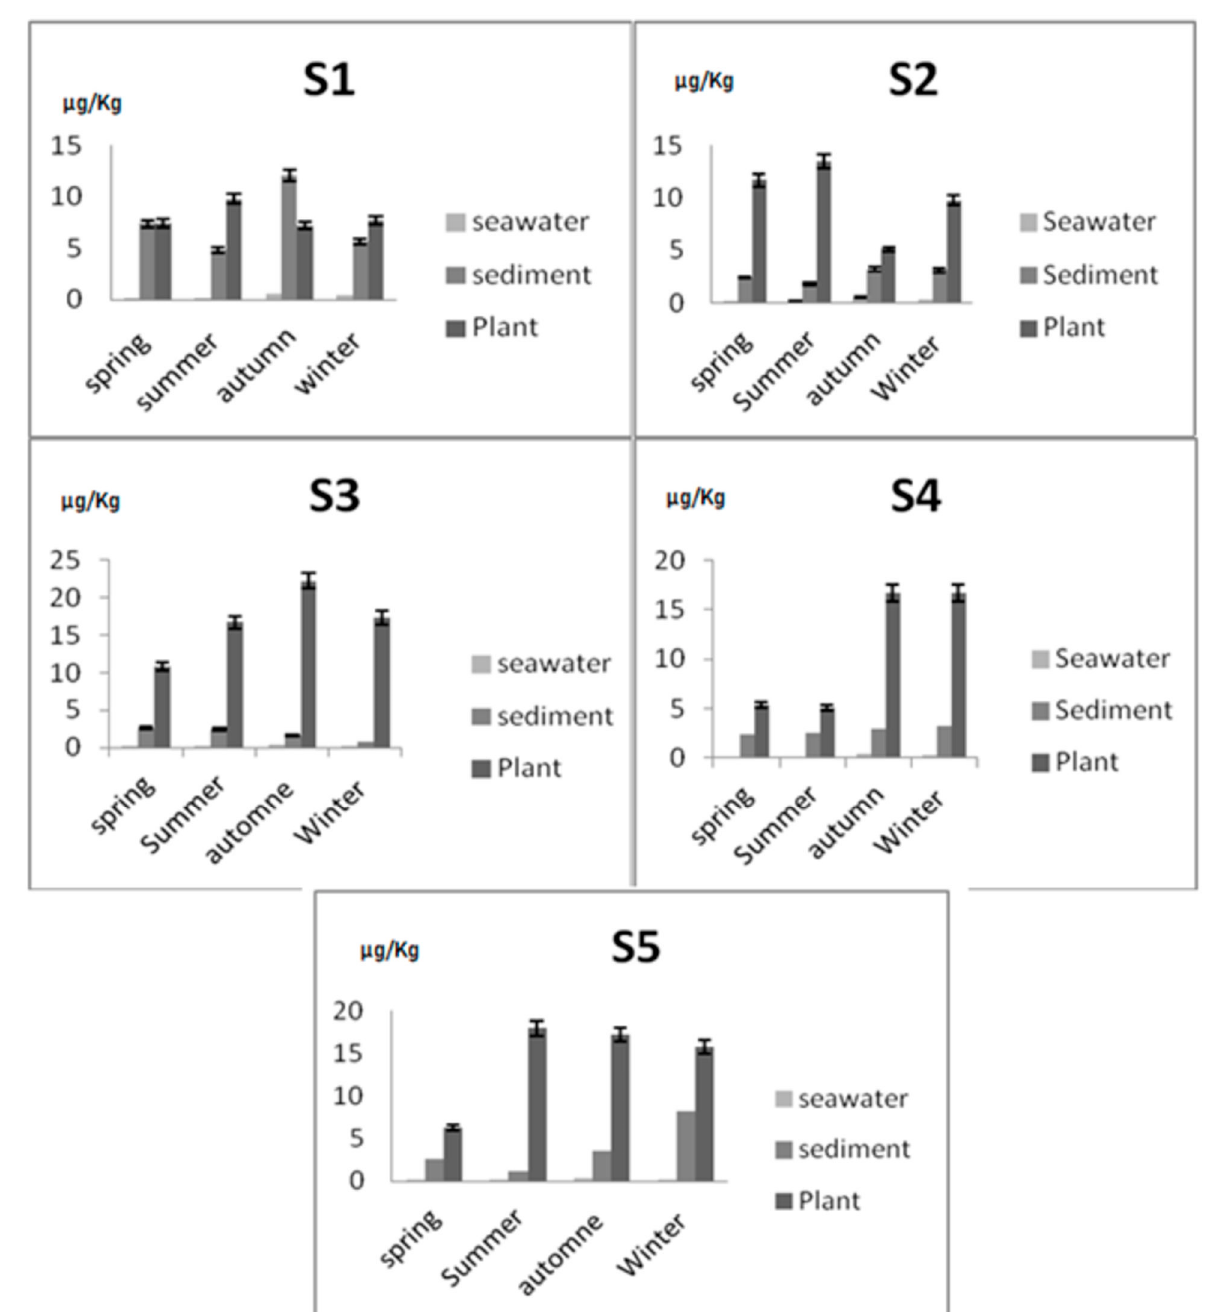
Figure 2. Hg concentration in some environmental samples (seawater, sediment, plant) from different sites according season ( µ g/kg).